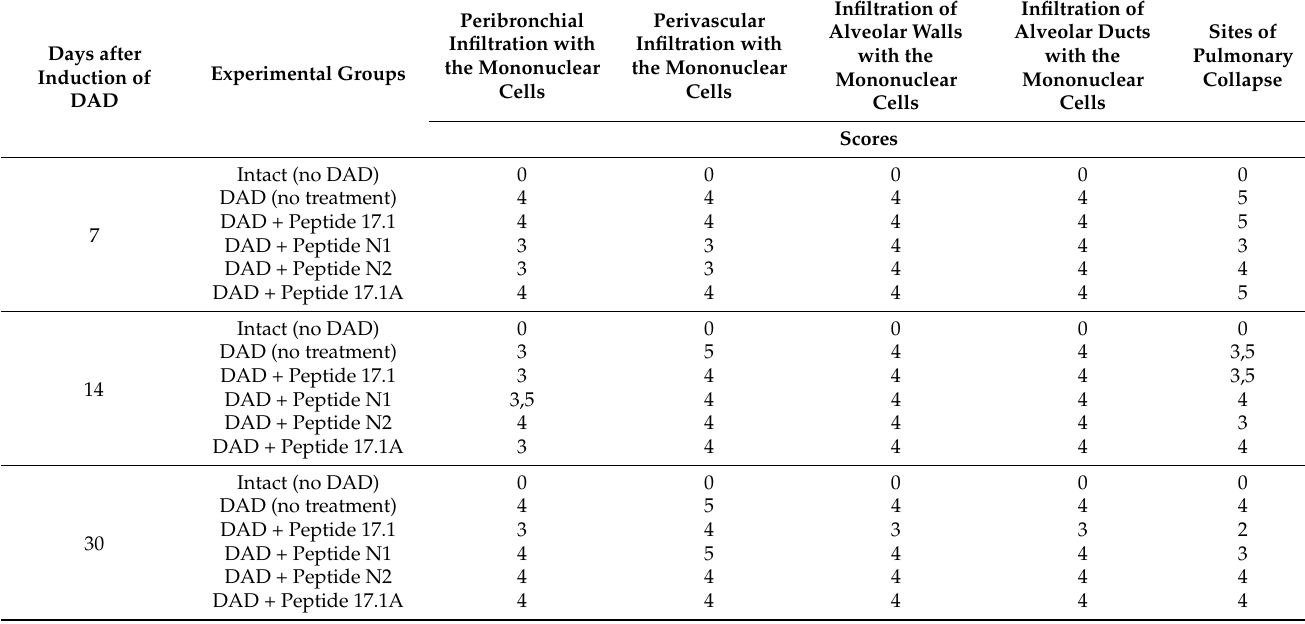
Days after Induction